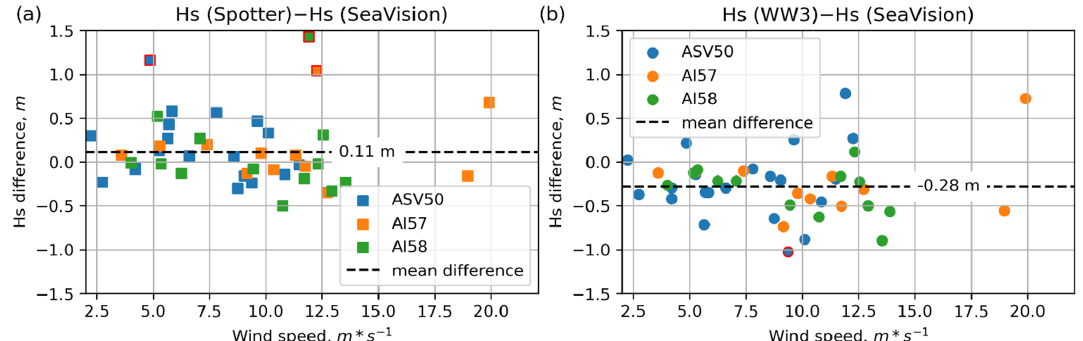
Figure 5. Difference in the significant wave height ( H s ) estimates for all stations as a function of the wind speed: Spotter buoy (“ground truth”) minus SeaVision (a) ; WW3 minus SeaVision (b) . Dash lines mark the mean difference across all data points. Red squares and circles mark differences higher than 1m.